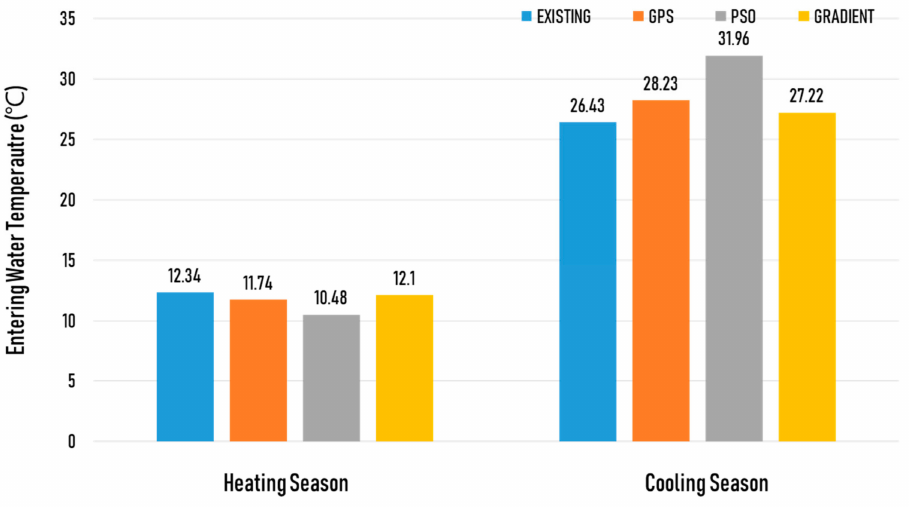
Figure 11. Average entering water temperature of a heat